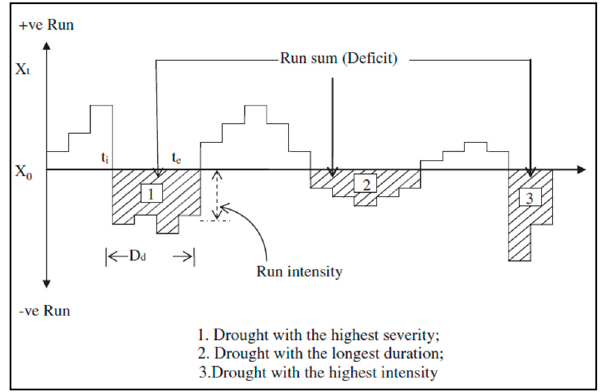
Figure 4. The run theory showing the various drought characteristics it captures.